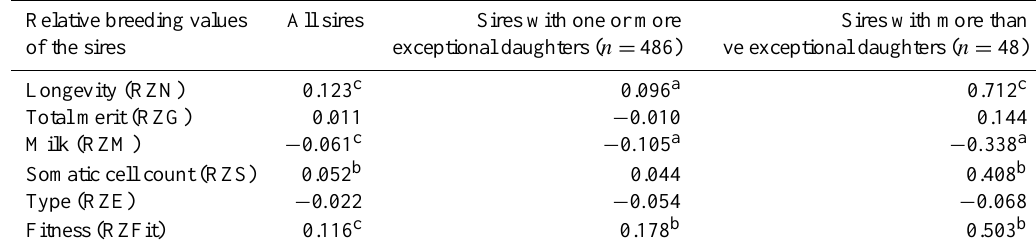
Table 5. Pearson correlations among relative breeding values of sires with the proportion of daughters classified as exceptional cows (EX) for all sires and with sires with at least one daughter and with more than five daughters classified as exceptional cow. Relative breeding values All sires Sires with one or more Sires with more than of the sires